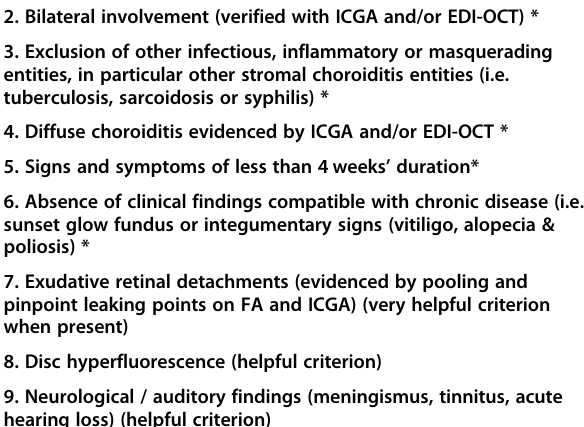
Table 4 Diagnostic criteria for initial onset VKH Disease